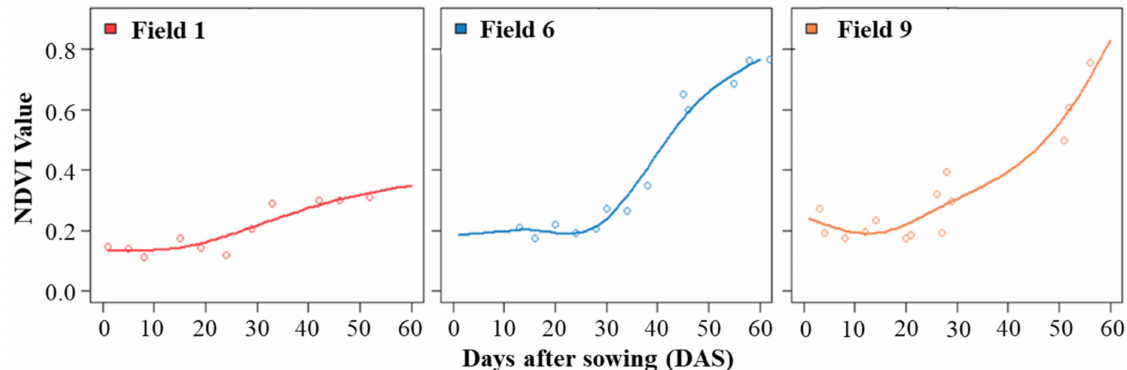
Figure 4. Examples of preprocessing multitemporal NDVI of PlanetScope by smoothing spline in a certain pixel for Fields 1, 6, and 9. Points represent observed NDVI values at a certain day after sowing (DAS) derived from PlanetScope imagery, and the lines represent the estimated curves from the smoothing